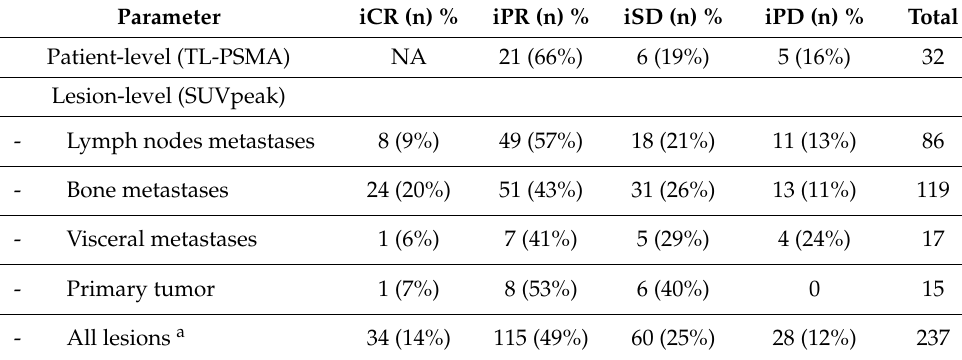
a Al lesions includes: primary tumor, lymph node, bone and visceral metastases. Legend: iCR = Imaging complete response, iPD = Imaging progression disease, iPR = Imaging partial response, iSD = Imaging stable disease, PSMA = Prostate specific membrane antigen, SUV = Standardized uptake value, TL-PSMA = Total lesion PSMA.